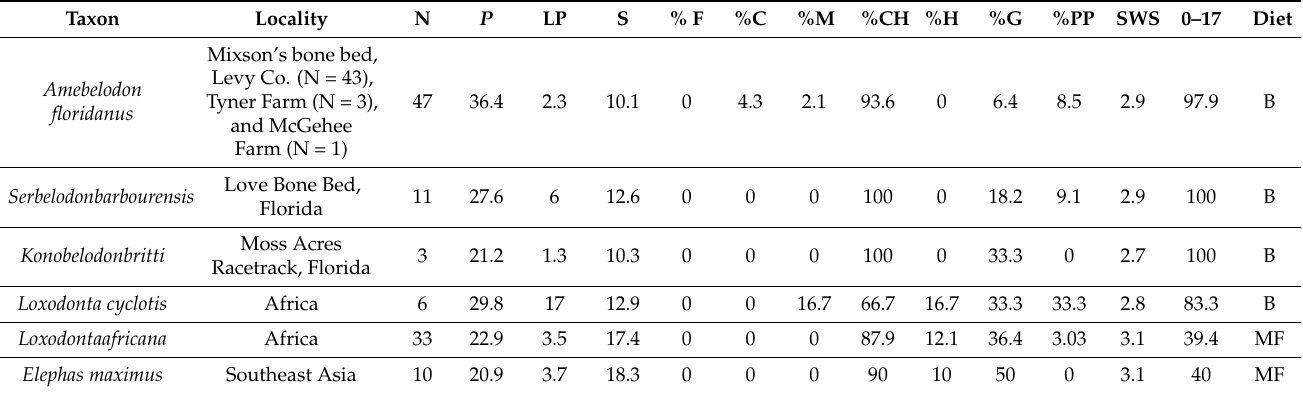
Table 3. Summary Microwear Statistics.